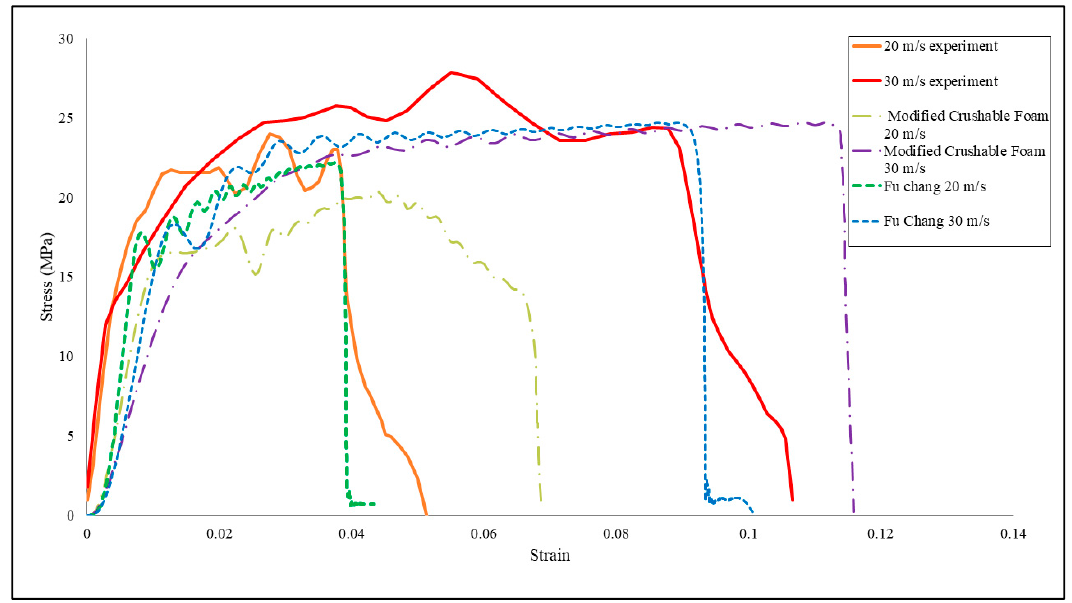
Figure 16. Comparison of the stress–strain curve between the experiment and the result obtained from Fu-Chang foam and modified crushable foam under loading speeds of 20 and 30 m/s.